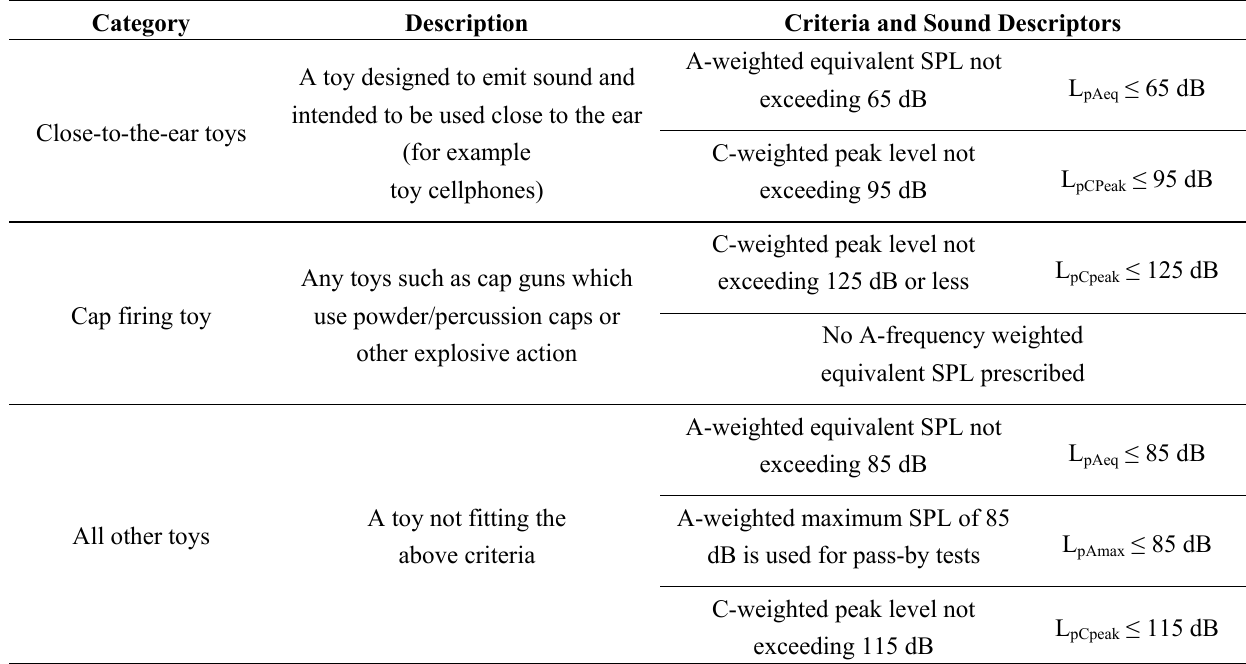
Table 2. Toy categories and criteria of the AS/NZS ISO 8124.1:2010 (and 2013) standard.